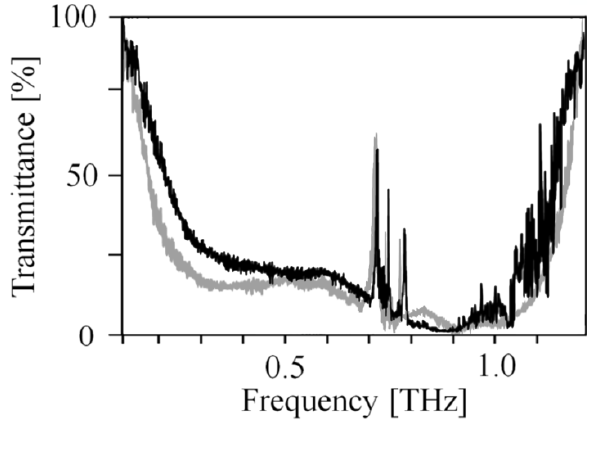
Figure 9. Localized modes formation in the electromagnetic band gap. The terahertz waves with the selected wavelengths can resonate with the defect cavity and transmit the crystal. The black and gray lines show the measured and calculated results,